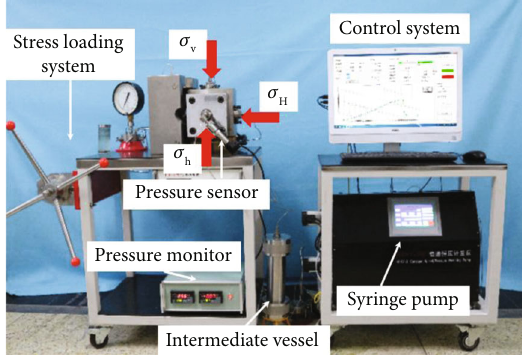
Figure 2: Real picture of small size true triaxial fracturing simulation experimental